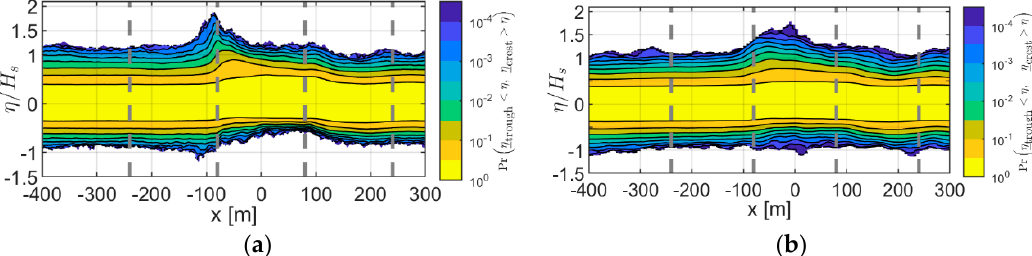
Figure 15. Crest and trough distribution over the shoal for H6T12. ( a ) for 1D long-crested waves, and ( b ) for short-crested waves, respectively.